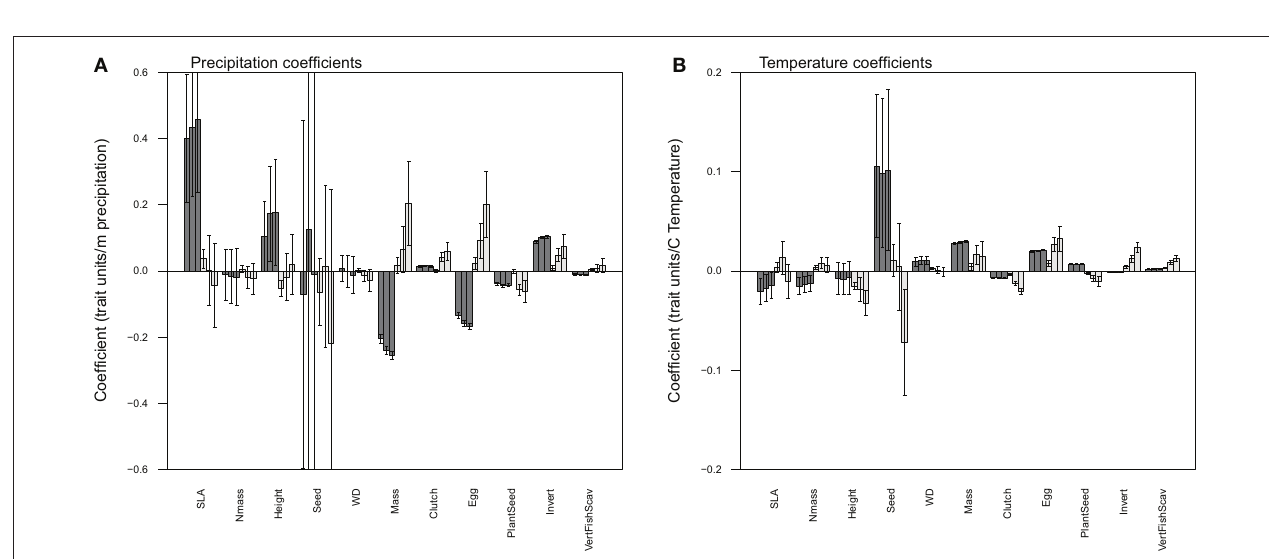
FIGURE 5 | Mean regression coefficients relating the 1, 5 or 10-year averages of precipitation (A) and temperature (B) to each of eleven functional traits. For each set of six bars, the first three (dark) bars indicate the mean spatial coefficient from 1, 5 or 10-year models (respectively) and the three right (light) bars the mean temporal coefficient in 1, 5 or 10-year models. The error bars indicate the 95% confidence